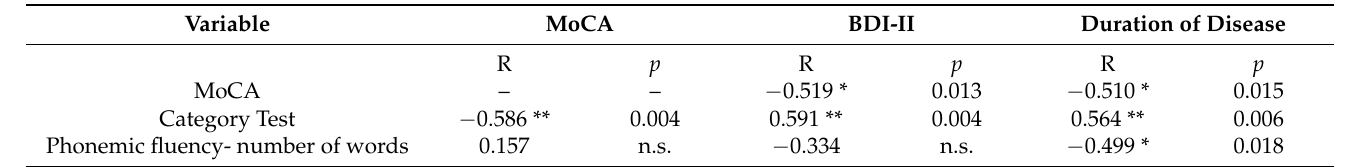
Table 3. Correlations in the group of patients with MS between duration of the disease, MoCA, BDI-II and Halstead Category Test and verbal